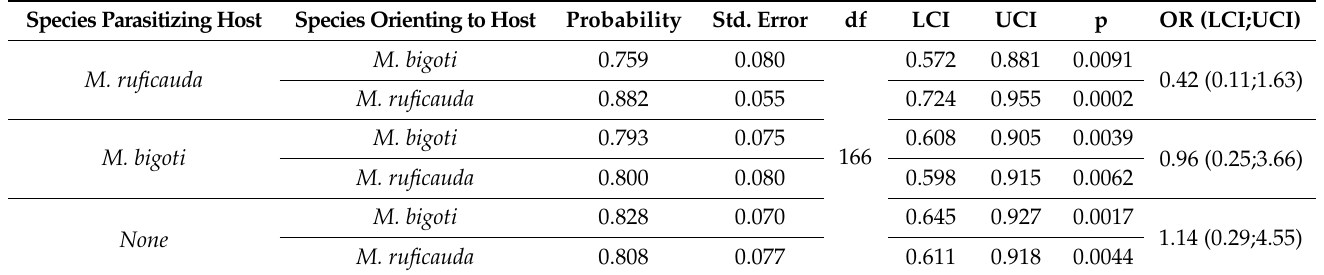
Table 5. Summary of the results of the model for the effect of interspecific competence on the probability of orienting to C. signaticollis for M. ruficauda and M. bigoti . The table shows the predicted probabilities and odds ratios for host orientation experiments. df: Degrees of freedom. LCI and UCI: Lower and upper confidence interval for the estimated probability. OR (LCI; UCI): Odds ratio with a lower and upper confidence interval for the odds ratio between the species that are orienting to the host. It should be noted that if the confidence interval includes 1, the OR is not significant, rendering no difference between groups. None: corresponds to the positive control for orientation of both species to a healthy C. signaticollis